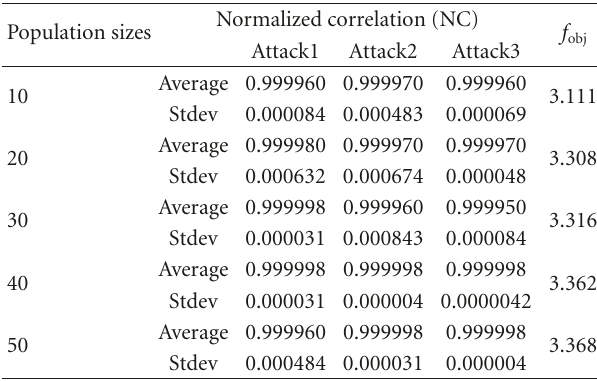
Table 2: Average results for di ff erent population sizes.